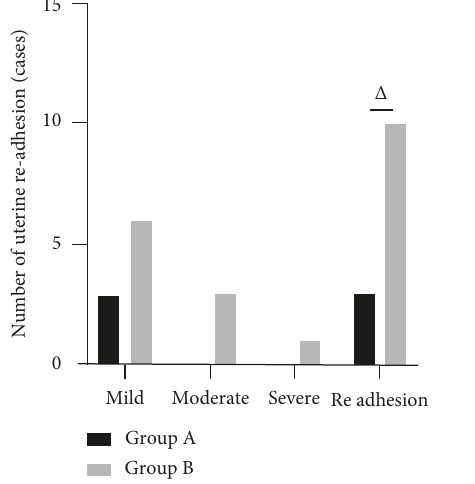
Figure 8: Number of uterine readhesion. Note . Δ indicates P < 0 . 05 for the difference between groups A and B.